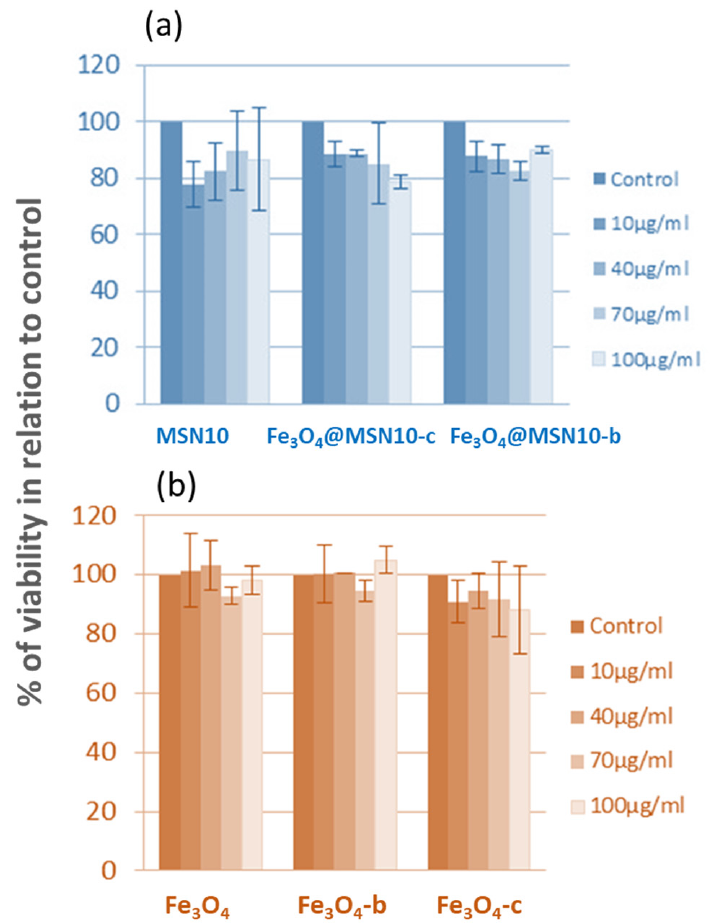
Figure 9. Influence of Fe 3 O 4 @MSNs ( a ) or Fe 3 O 4 NPs ( b ) on cell viability in DLD1 human colon cancer cells. Cells were treated with increasing concentrations of six different nanoparticles over 48 h; cell viability was determined by MTT assay. Bars represent the mean values obtained from at least three independent experiments, each performed in triplicate.